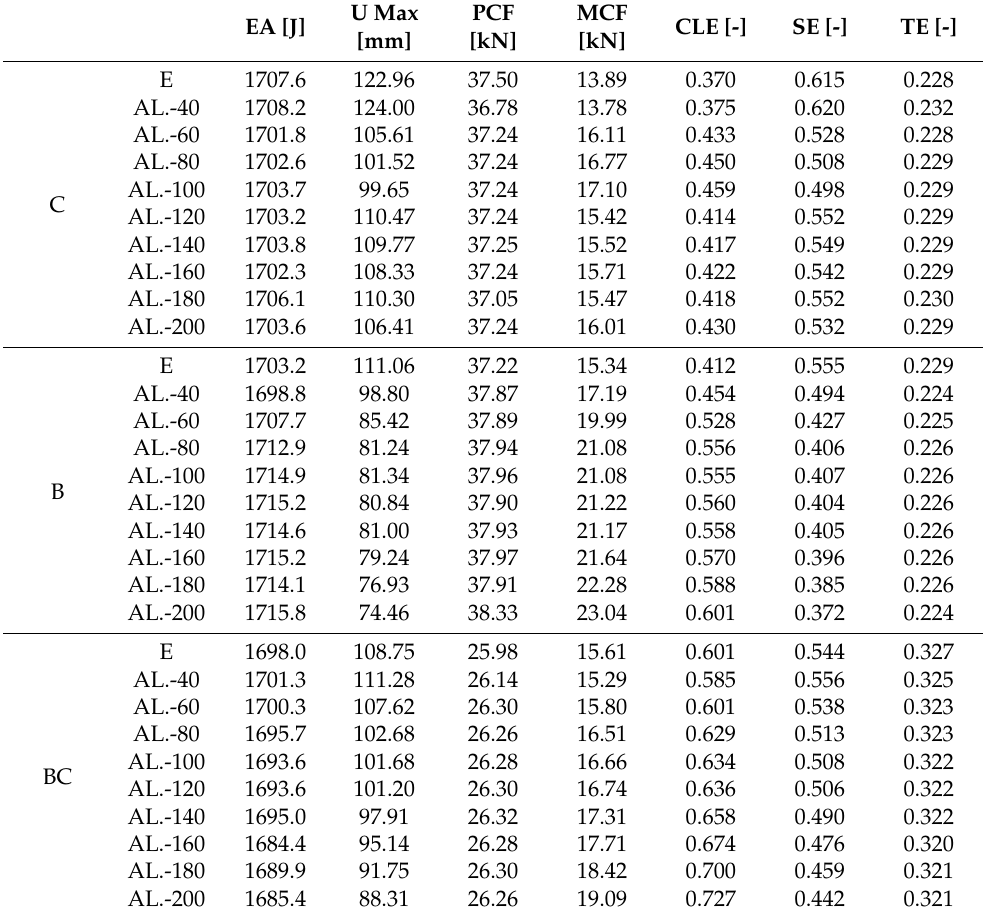
Table 3. Crashworthiness indicator of aluminum foam-filled columns with different